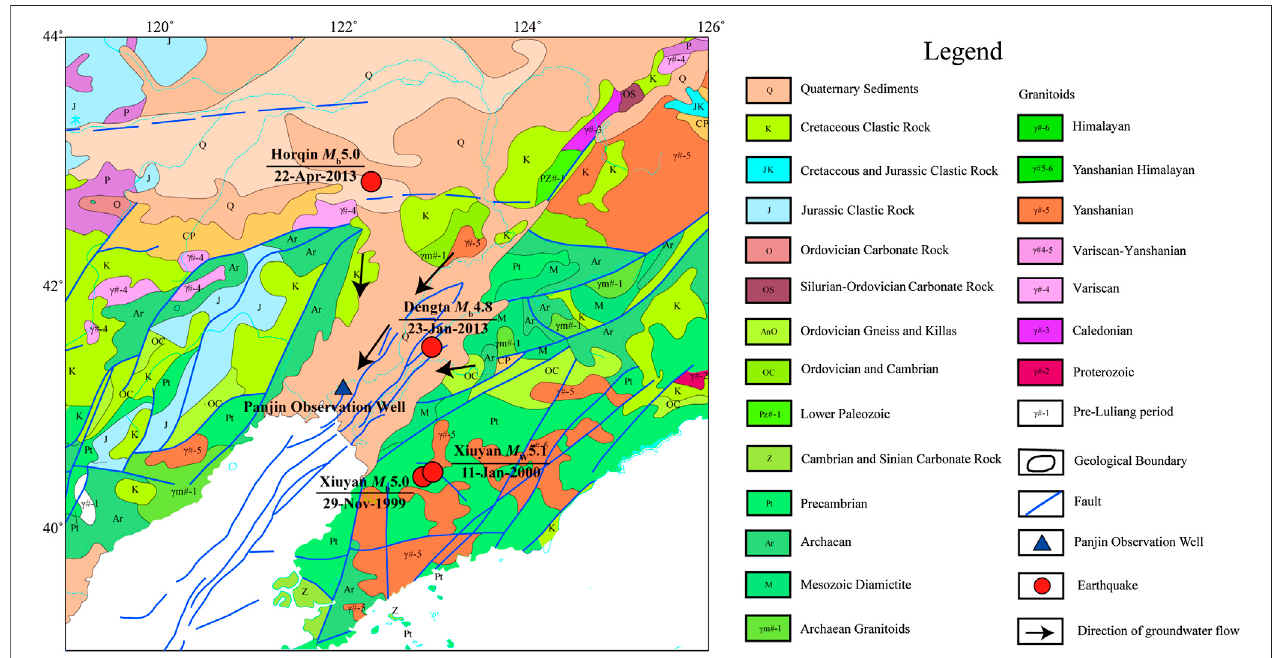
FIGURE 1 | Geographical location of Panjin observation well, Liaoning province, China. Red circles denote earthquakes of M ≥ 4.8 within a radius of 300 km (1994 – 2020). The black arrows represent the groundwater fl ow direction of the Neogene Guantao formation.